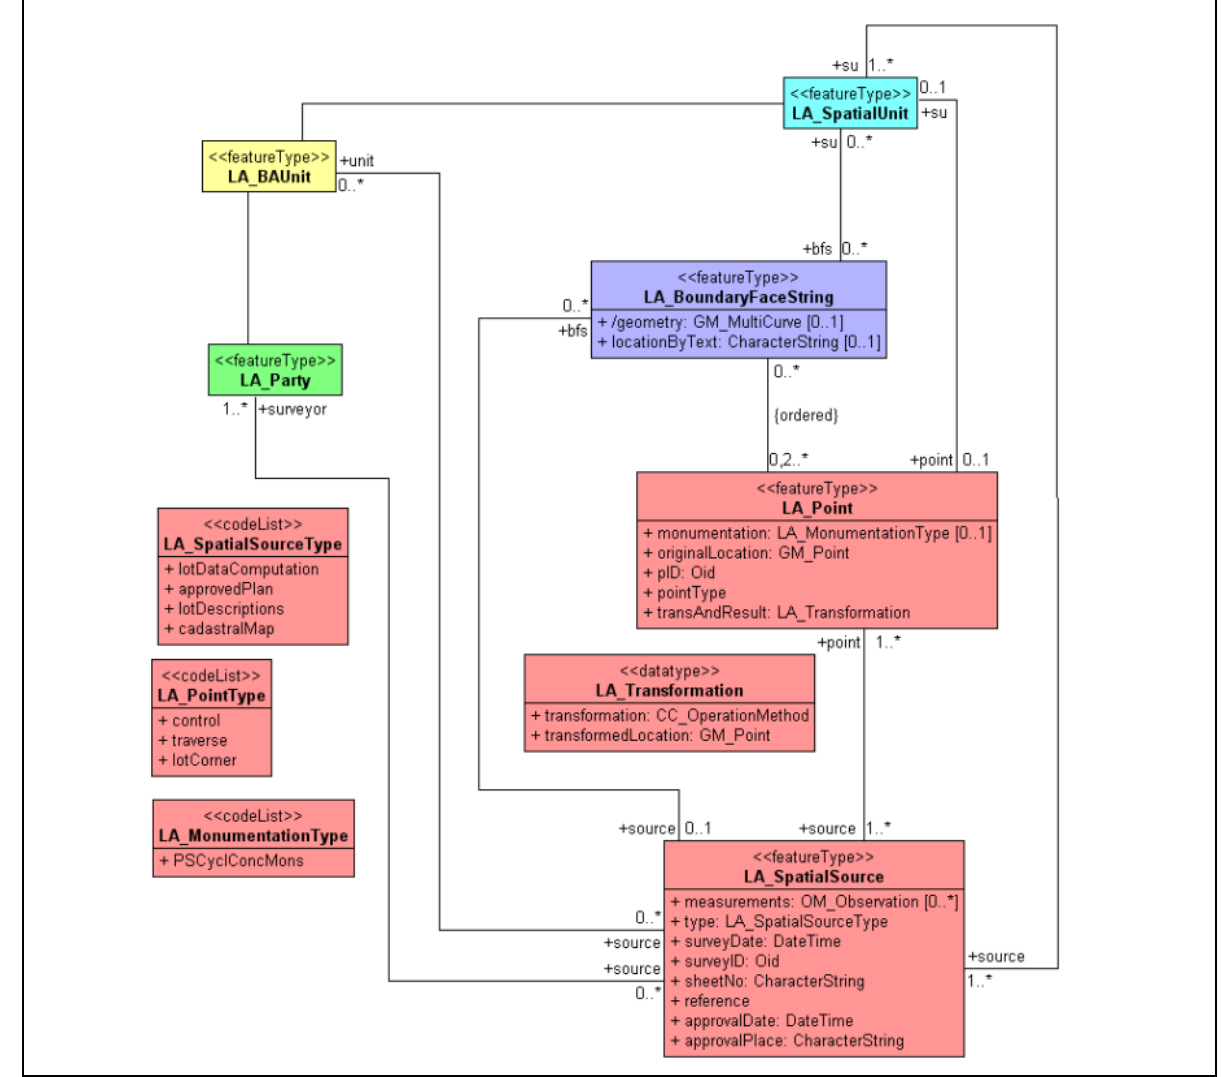
Figure 7 . Localized classes of the Surveying and Representation